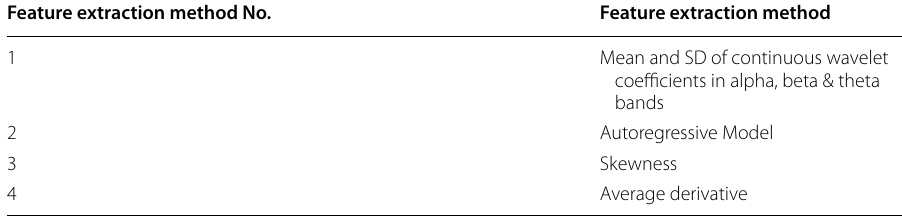
Table 2 Extracted features Feature extraction method